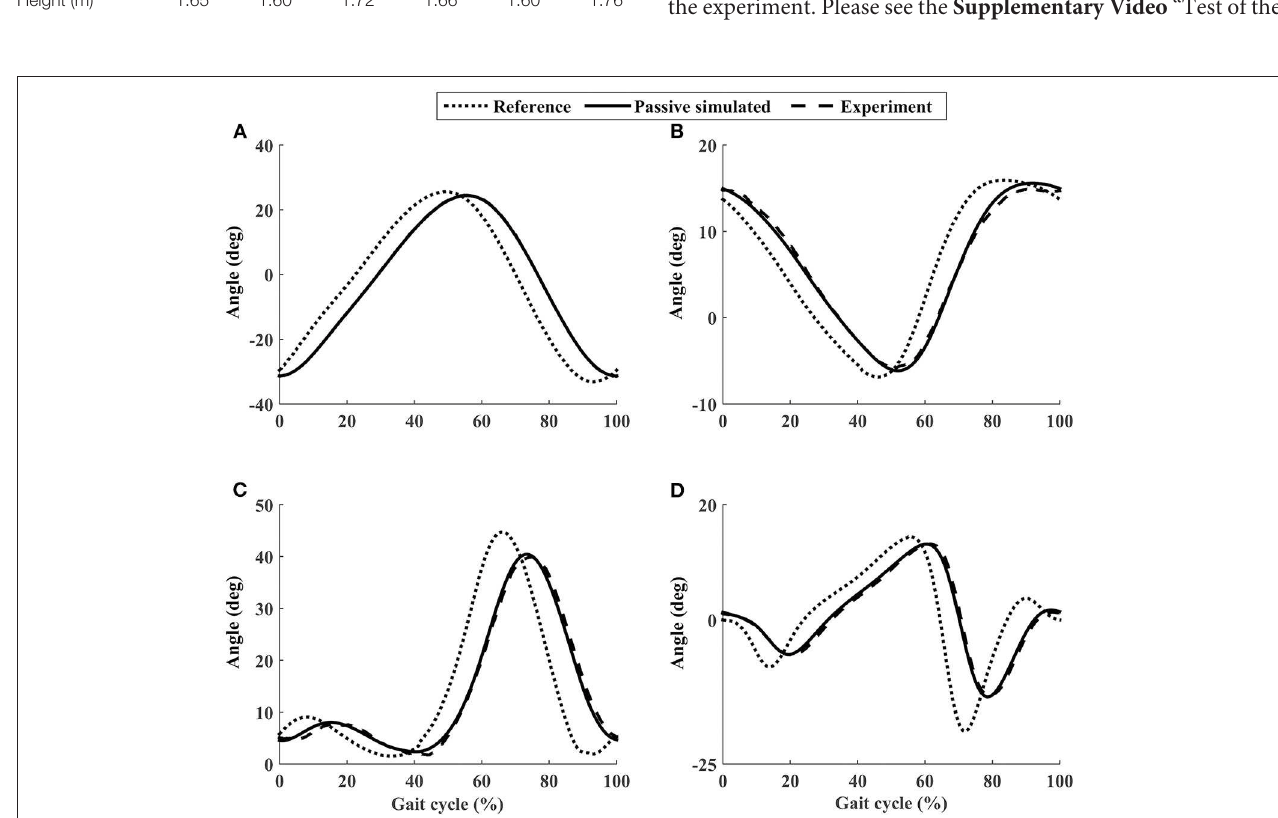
FIGURE 6 | The joint performance of the representative participant P1 using the ROWAS II in passive mode. (A) Shoulder joint. (B) Hip joint. (C) Knee joint. (D) Ankle joint.